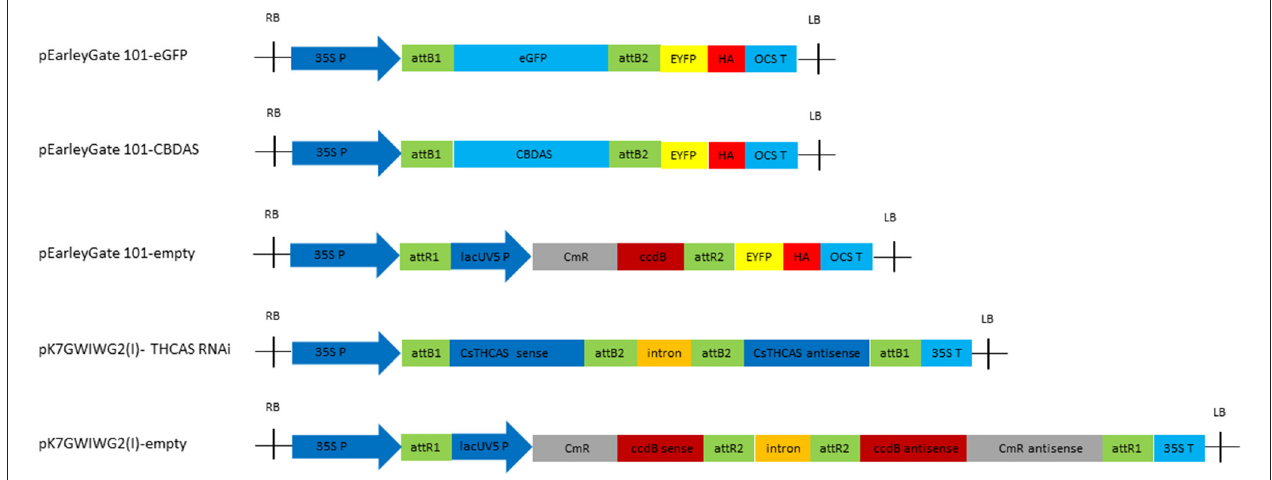
FIGURE 2 | Schematic diagram of the metabolic engineering constructs in this